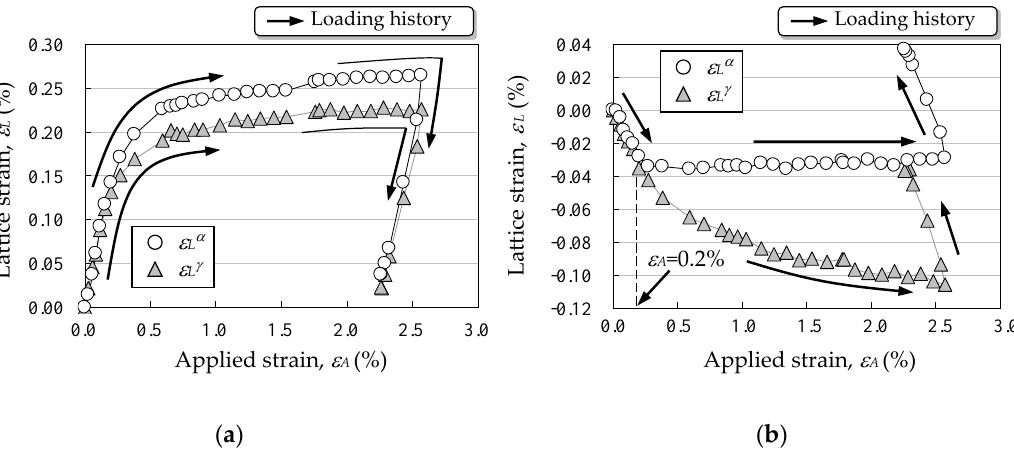
Figure 11. Lattice strain evolution under tensile loading. ( a ) Axial direction, ( b ) Radial direction [14].